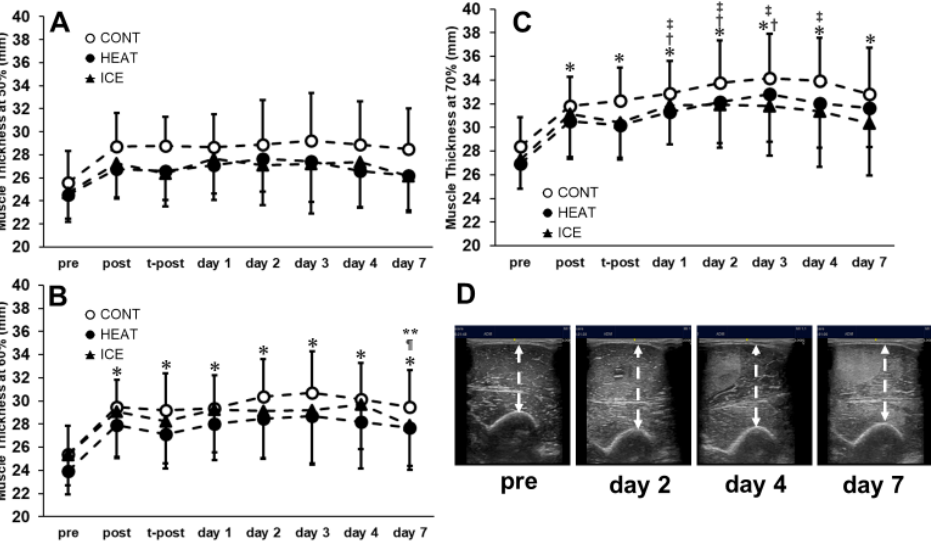
Figure 7. Changes in muscle thickness at 50% ( A ), 60% ( B ), and 70% ( C ) of the upper arm. Changes in muscle thickness and echo intensity of elbow flexor muscles after muscle damage protocol. ( D ) *, Significant compared with pre ( p < 0.05); †, signi fi cant compared with post; ‡, signi fi cant compared with t-post; ¶, significant compared with day 3; **, significant compared with day 4.